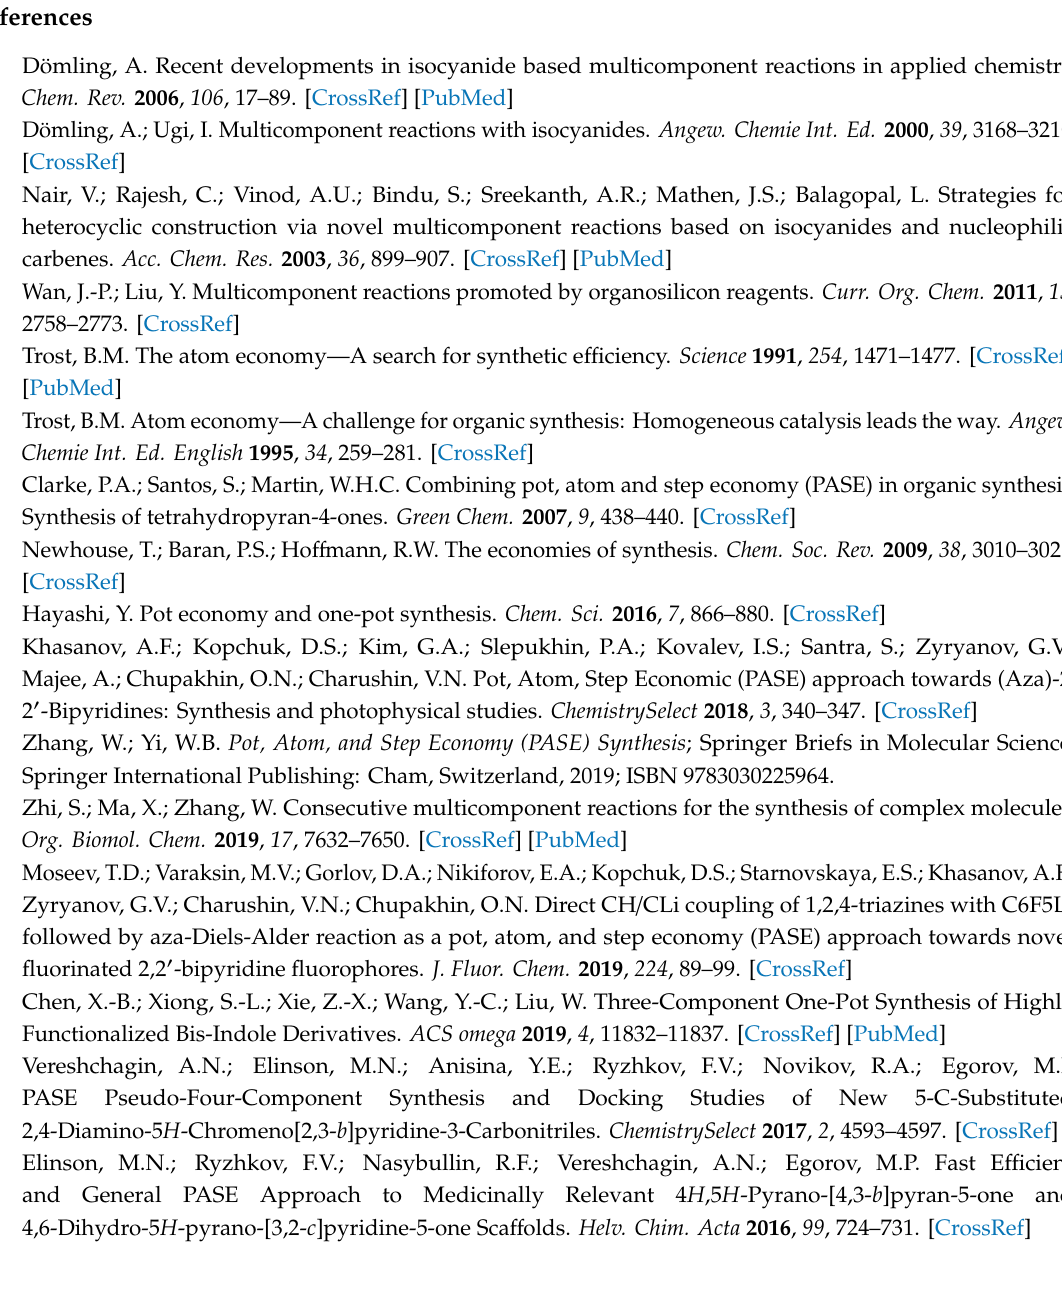
Supplementary Materials: 1 H and 13 C Spectra of synthesized compounds 4a – i and intermediate 5 (Figure S1–S22) , NMR monitoring spectra (Figure S23–S42), results of quantum chemical calculations with extended decimal point (Table S1) and figures of frontier orbitals (Figure S44–S55) are available